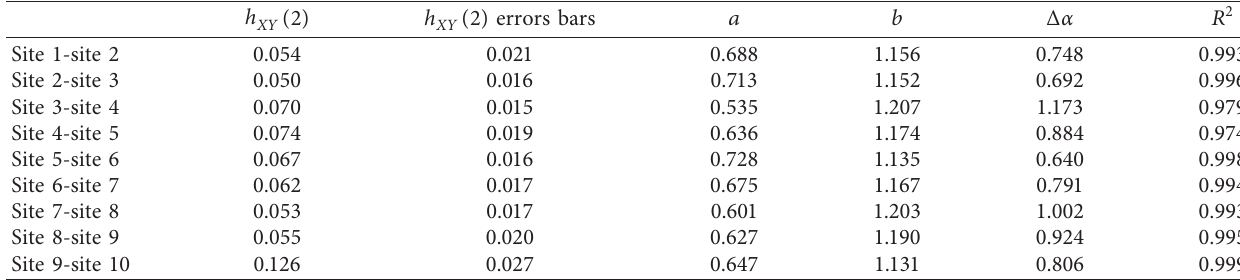
Table 2: Fitting results of binomial multifractal